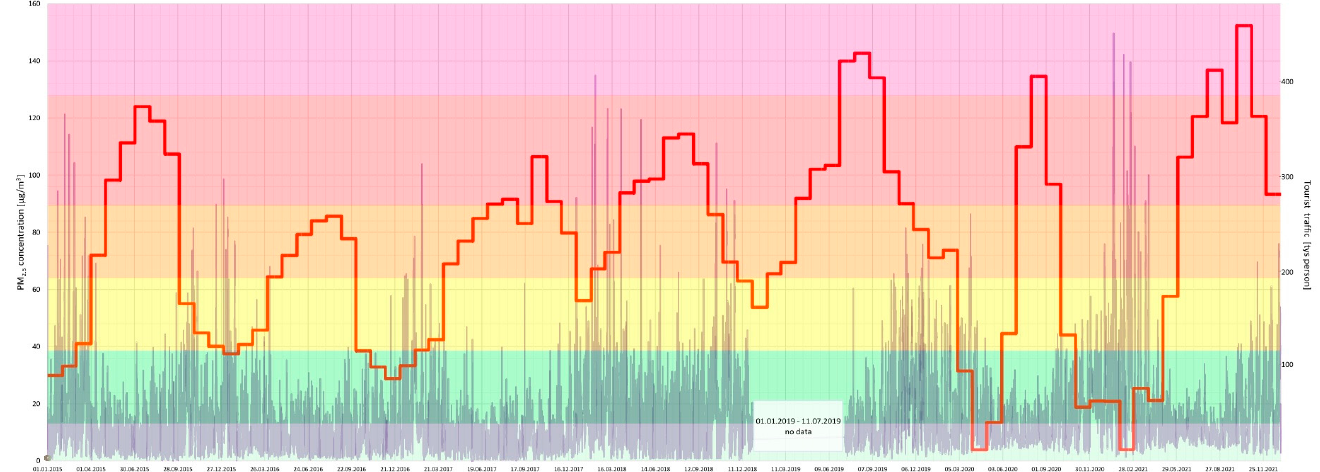
Figure 5. PM 2.5 concentration in relation to tourist traffic (the Gda ń sk agglomeration, years 2015– 2021). Source: own study.